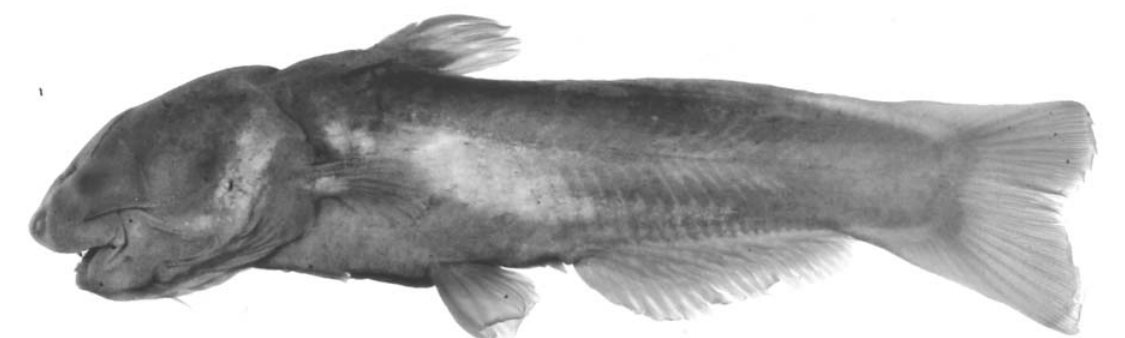
Fig. 45. Denticetopsis epa, new species, holotype, MZUSP 24060, 47 mm SL; Brazil, Pará, Igarapé do Limão, rio Tocantins, Baião (2°41’S,